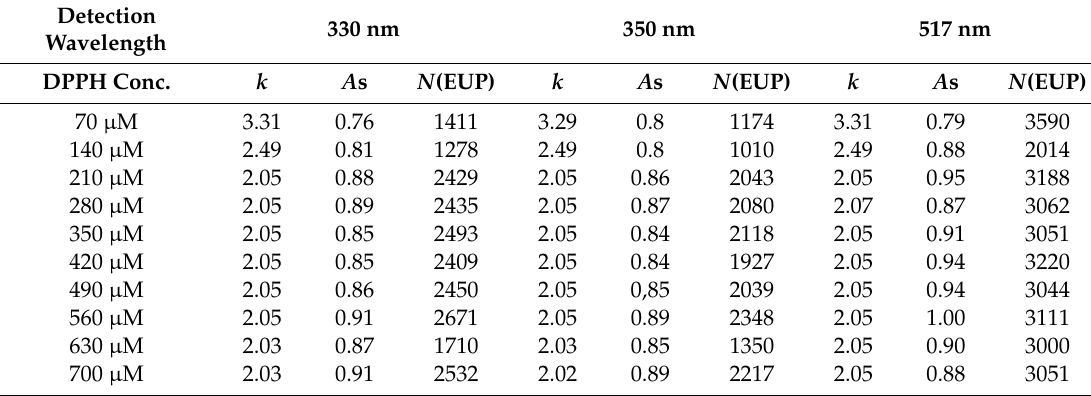
Figure 4. Scavenging effect of glutathione reduced (GSH) and ascorbic acid (vit. C) on DPPH free radical. Each value expressed as a mean ± SD ( n = 3). Conditions: 500 µ L of 0.7 mM DPPH in methanol was mixed with 500 µ L 0.7 mM GSH, or 500 µ L 0.7 mM ascorbic acid dissolved in 80% ( v / v ) MeOH / water. Table 2. k -Retention parameter, A s-tailing factor, and N -theoretical plate number values for DPPH standard in the HPLC system